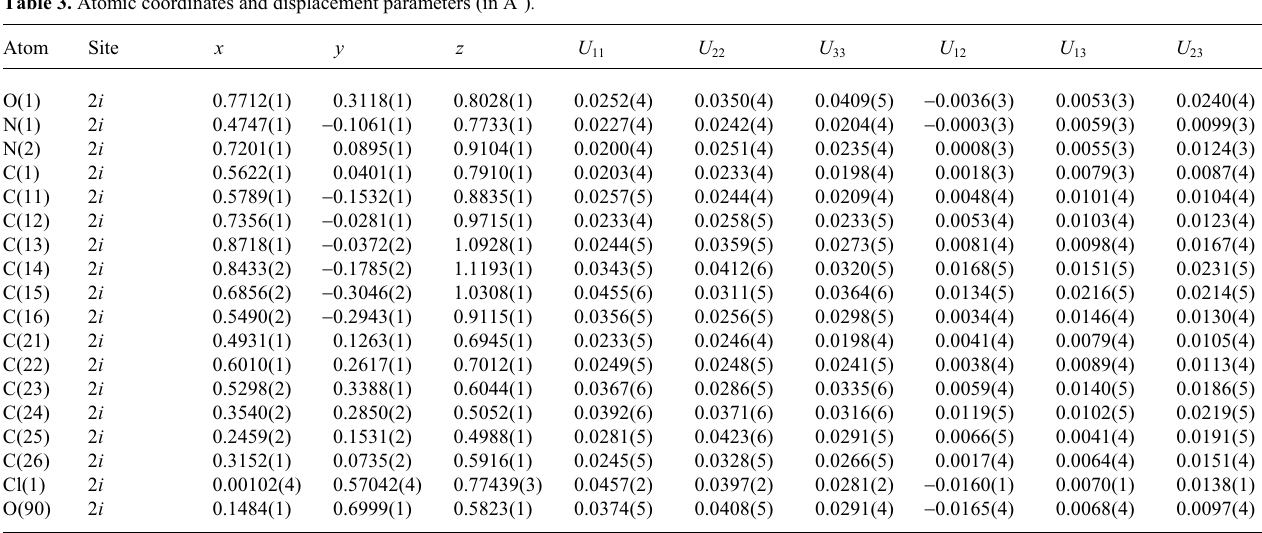
Table 3. Atomic coordinates and displacement parameters (in Å 2 ) .